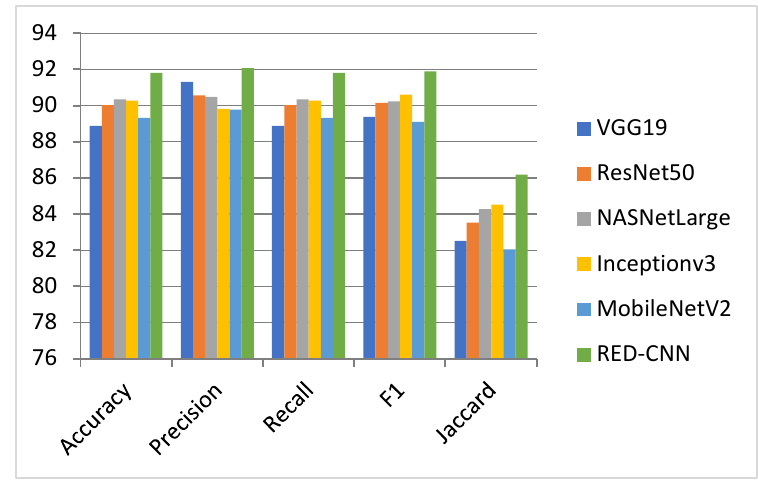
Figure 8. The evaluation index for different networks of different types.